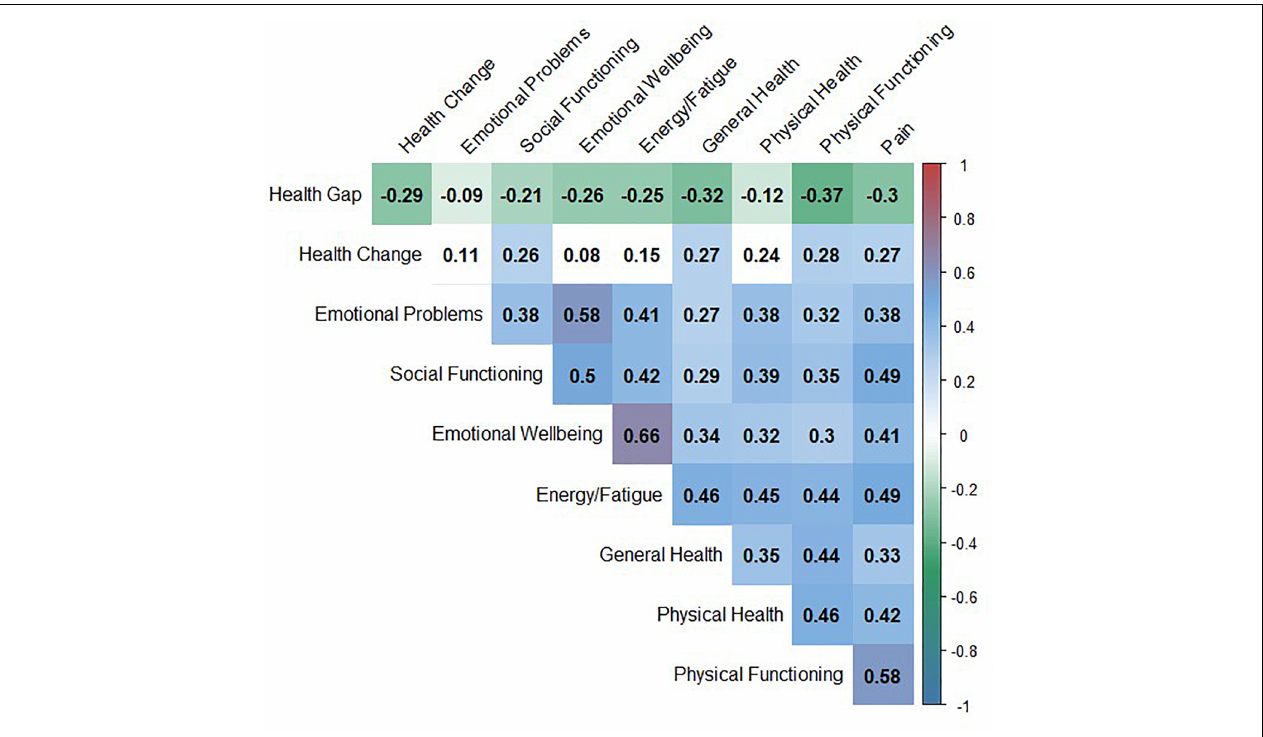
FIGURE 1 | Correlation matrix: univariate correlation between the compound Health Gap and SF-36 domains.